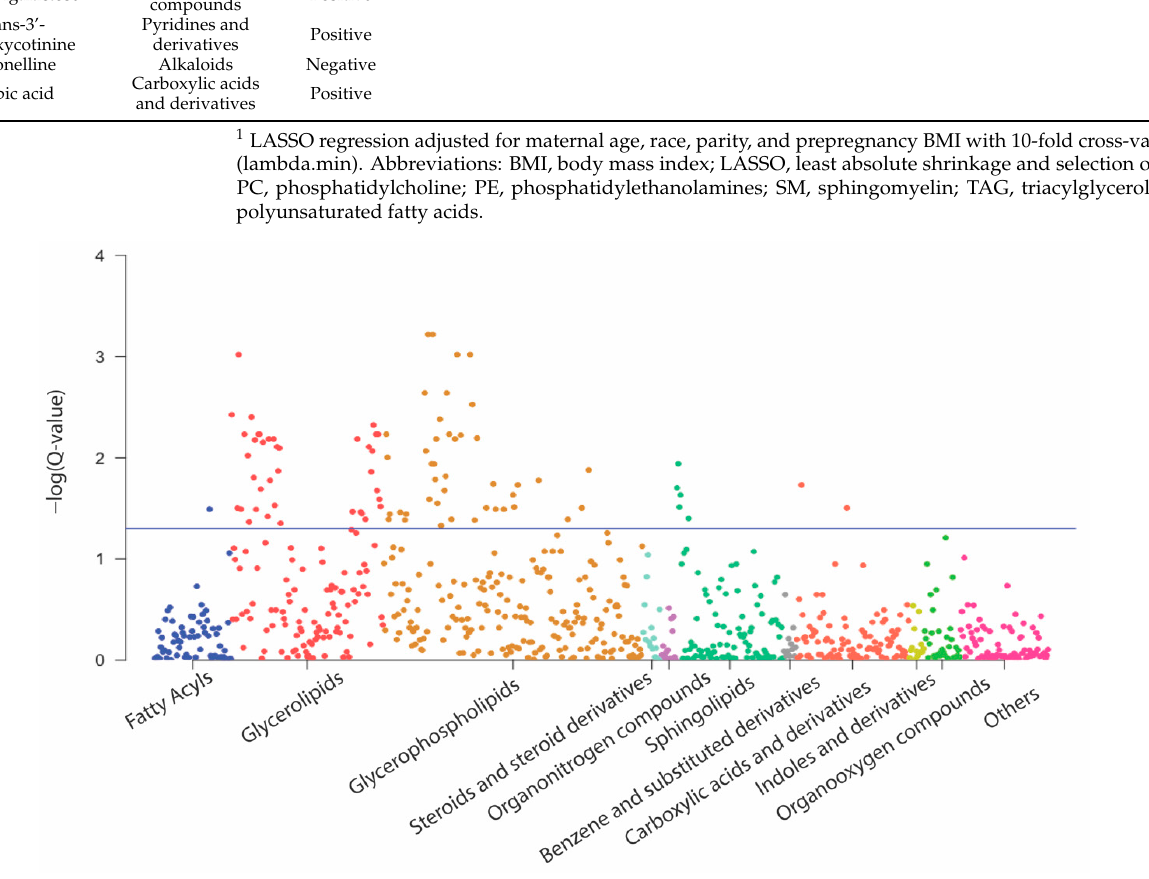
Figure 2. Manhattan plot for associations between metabolites at 32 weeks of gestation and total gestational weight gain (GWG) and by metabolic class in linear regression models adjusted for age, race/ethnicity, parity, and prepregnancy BMI and corrected for the multiple comparisons using the Benjamini–Hochberg procedure, with false discovery rates (FDRs) of < 0.05 as the statistically significant level. The horizontal lines represented the adjusted p values (i.e., Q value) of 0.05. “Others” included 76 metabolites in classes that contained less than 10 metabolites.